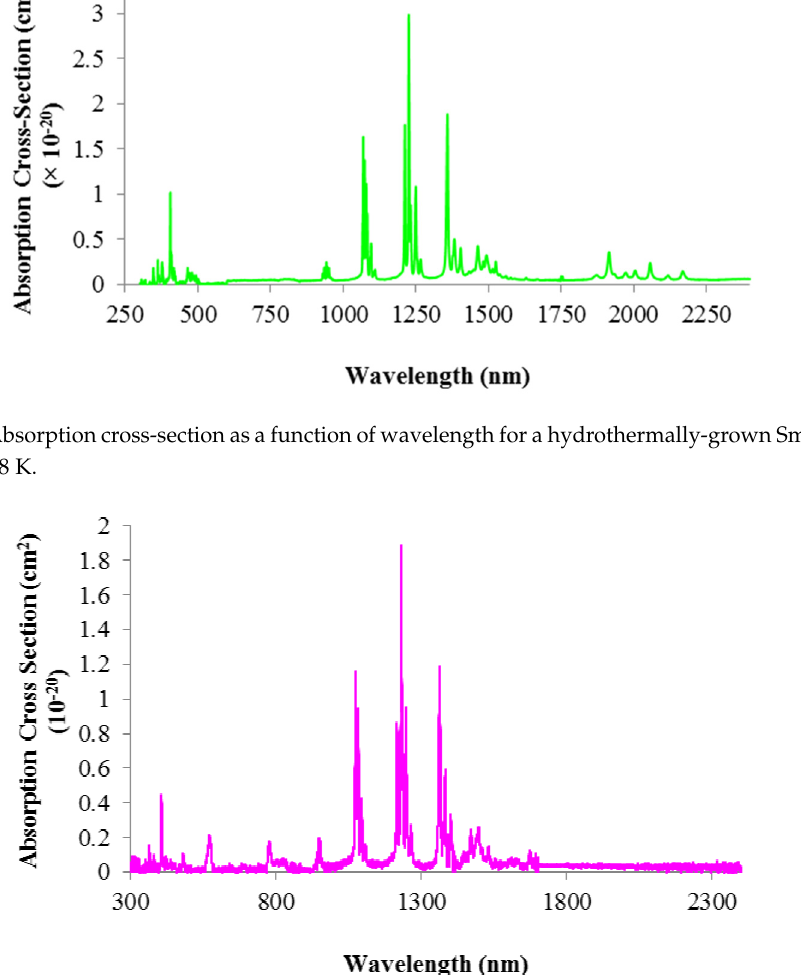
Figure 40. Normalized absorption cross-section as a function of wavelength in the region from 1050 to 1100 nm, for the Sm-doped materials Sm:YAG (green) and Sm:LuAG (blue).